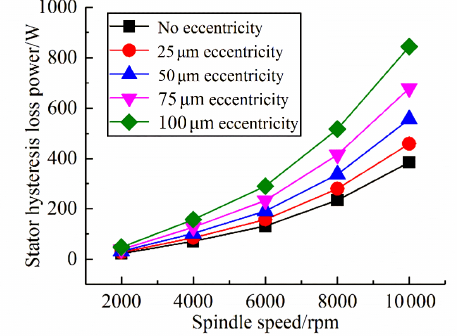
Figure 9. The rotor eddy current loss power with different rotating speed and eccentricities.